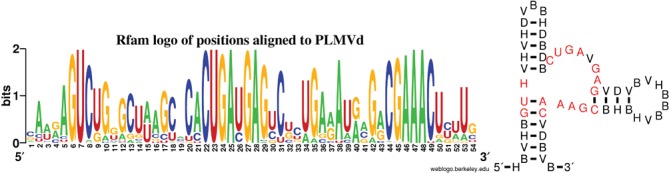
(Left) Sequence conservation for the 56 nt consensus sequence for type III hammerhead ribozymes from version 11.0 of the Rfam database (54); image from http://rfam.sanger.ac.uk/family/RF00008#tabview=tab3. (Left) Sequence logo of conservation at positions aligned with the 54 nt Peach Latent Mosaic Viroid (PLMVd) AJ005312.1/282-335 from the hammerhead ribozyme type III seed alignment sequences from Rfam family RF00008. In-house program used to determine frequencies of positions aligned to those of PLMVd; sequence logo generated with WebLogo (64) (web server at http://weblogo.berkeley.edu/). The 15 positions 6–7, 22–25,27–29, 44–49 of PLMVd had sequence conservation in excess of 96%, while cleavage site C at position 8, adjacent to region 6–8, was conserved in 94.9367% of RF00008 seed alignment sequences. RNAiFold was subsequently used to solve the inverse folding problem with consensus structure of PLMVd used as target, with sequence constraints at positions 6–8, 22–25, 27–29, 44–49, as explained in text. Resulting from this analysis, the sequence constraints for RNAiFold were defined to be HBVHBGUHVH VHDVBBHDBD BCUGAVGAGV DVBVHBBBVH BHBCGAAACV DBVB. (Right) Sequence constraints for RNAiFold with indicated target secondary structure. The 15 positions 6-7, 22–25,27–29, 44-49 having over 96% sequence conservation in the seed alignment of RF00008 were constrained to be those in PLMVd AJ005312.1/282-335, and the cleavage site 8 was constrained to be H (not G). All 38 remaining positions were constrained to be distinct from the corresponding nucleotides in PLMVd.